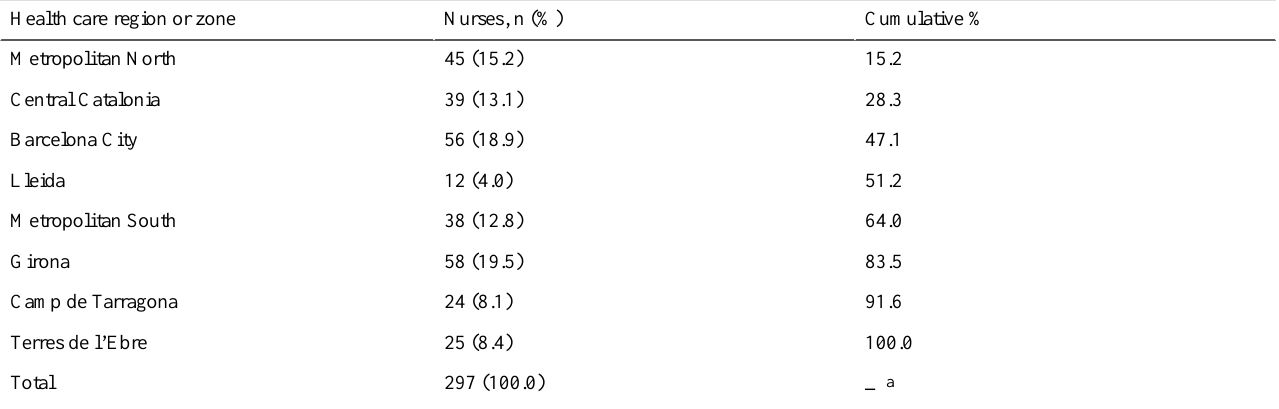
Table 7. Distribution of the family nurse group by health care region or